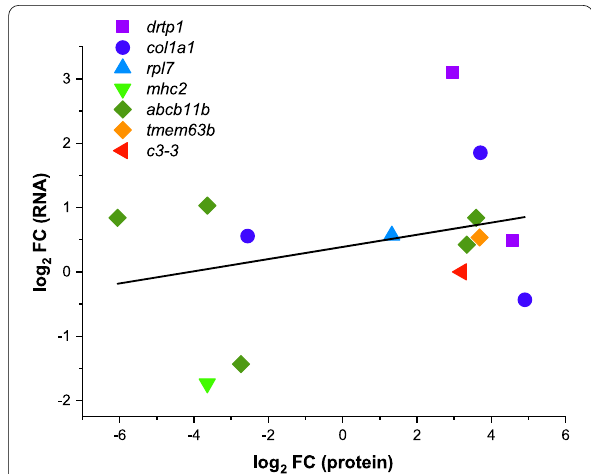
Fig. 9 Regression analysis of the correlation between differential protein concentrations and differential gene expression (F (1,12) 1.1339, p > 0.05, r 2 0.0863). Some proteins occur more = = frequently if they have been detected more than once in the contrast analysis of proteomic data. FC fold changes. Information about the = general function of the analysed proteins can be found in Table